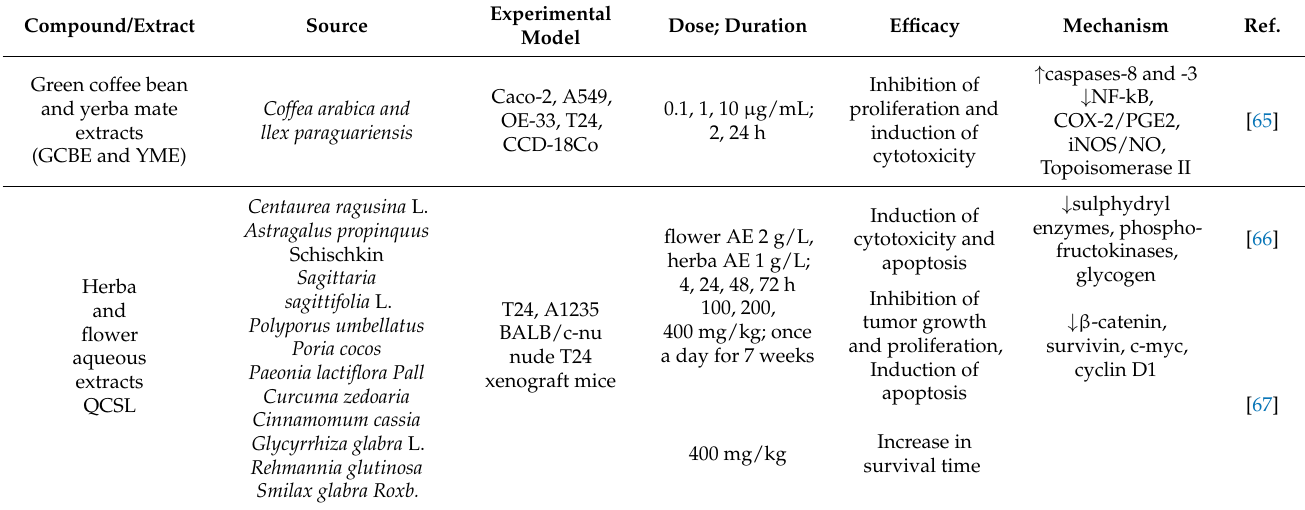
Table 3. Mixture Extracts inducing